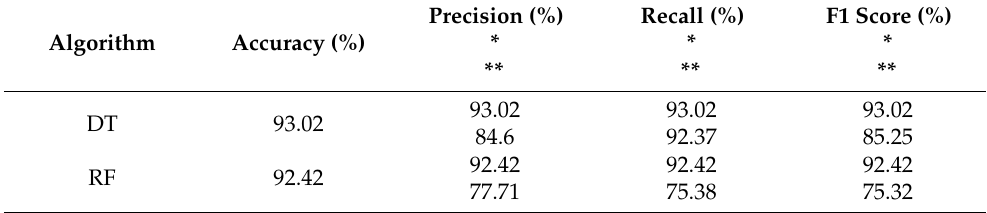
Table 2. AL selection test